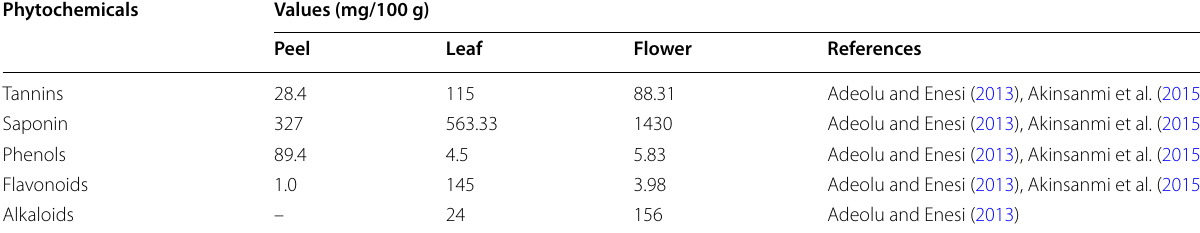
Table 3 Phytochemical composition of